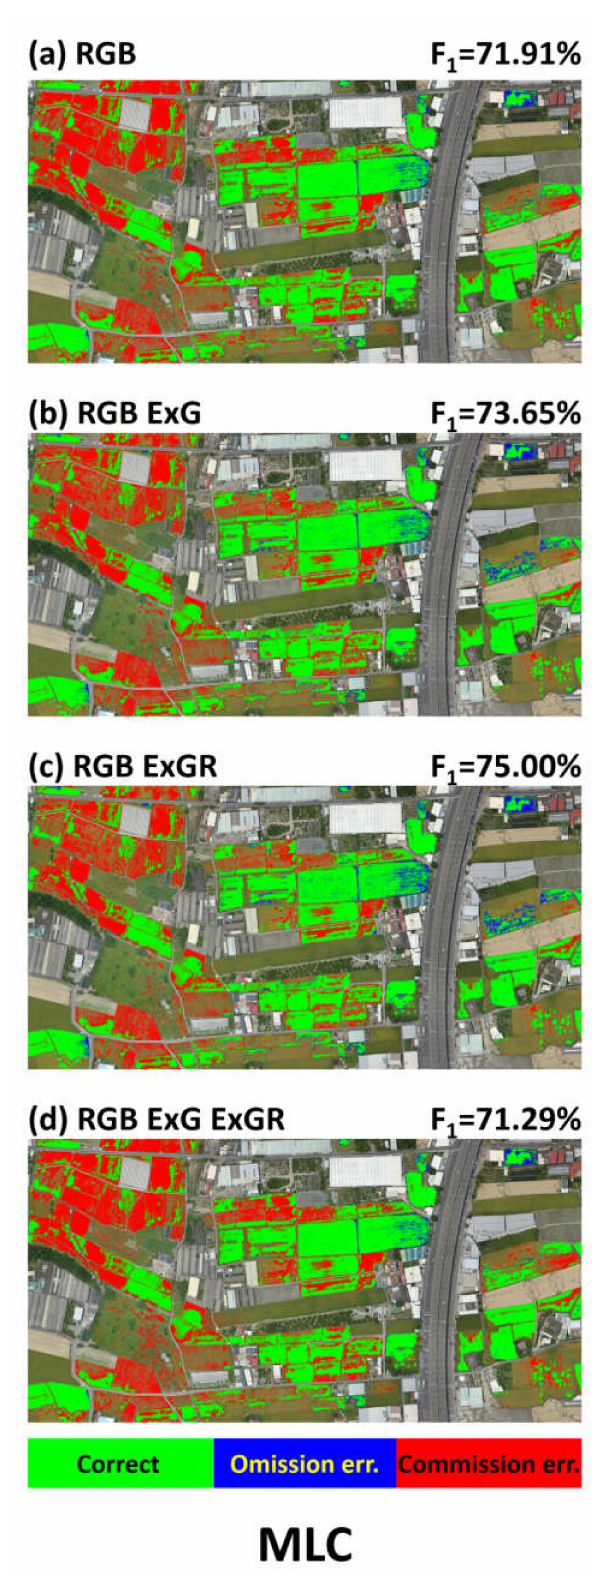
Figure 14. Results of MLC identification for rice lodging on 2017 testing dataset using various spectrum information: ( a ) RGB, ( b ) RGB + ExG, ( c ) RGB + ExGR, and ( d ) RGB + ExG +